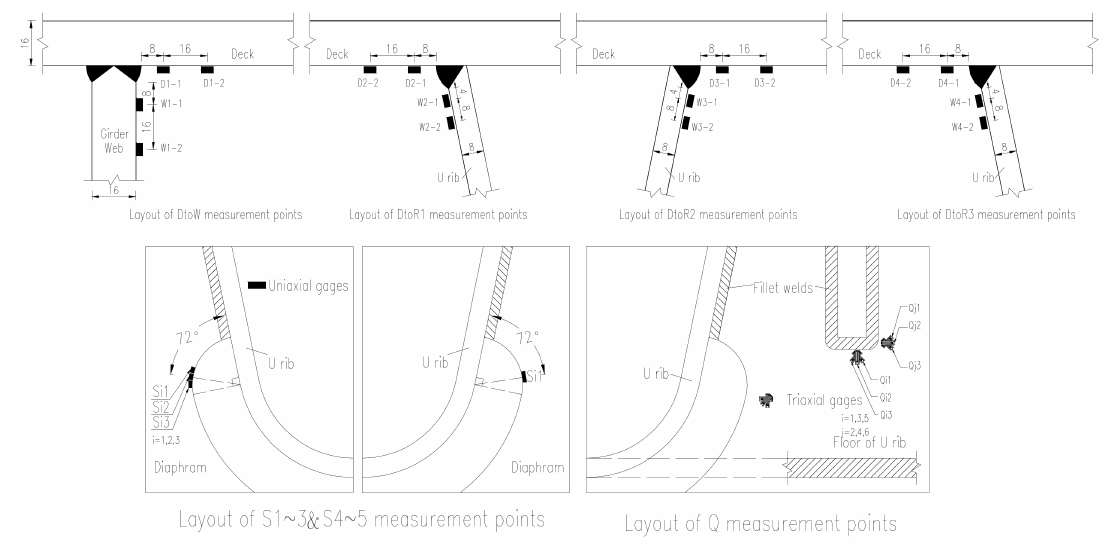
Figure 7. Layout details of strain